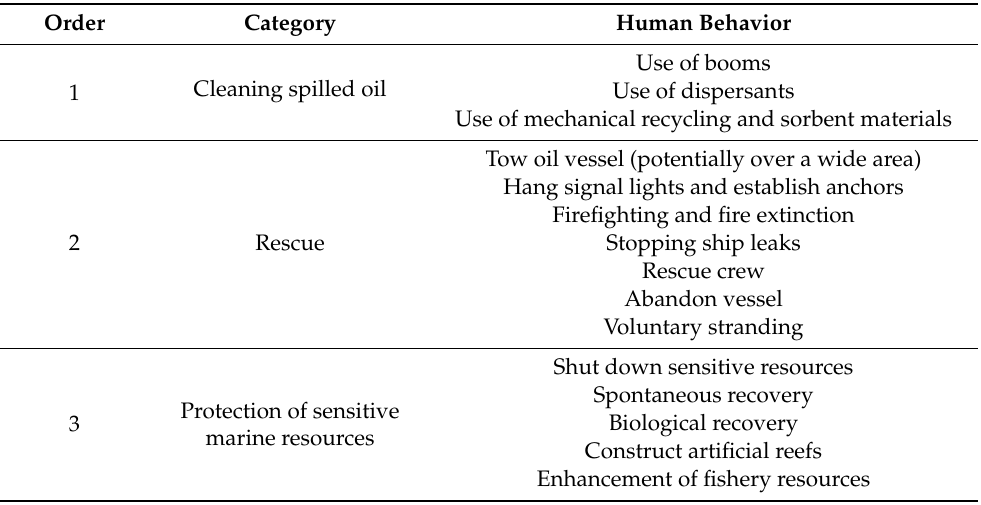
Table 3. Summary of human behaviors during a marine oil spill emergency.